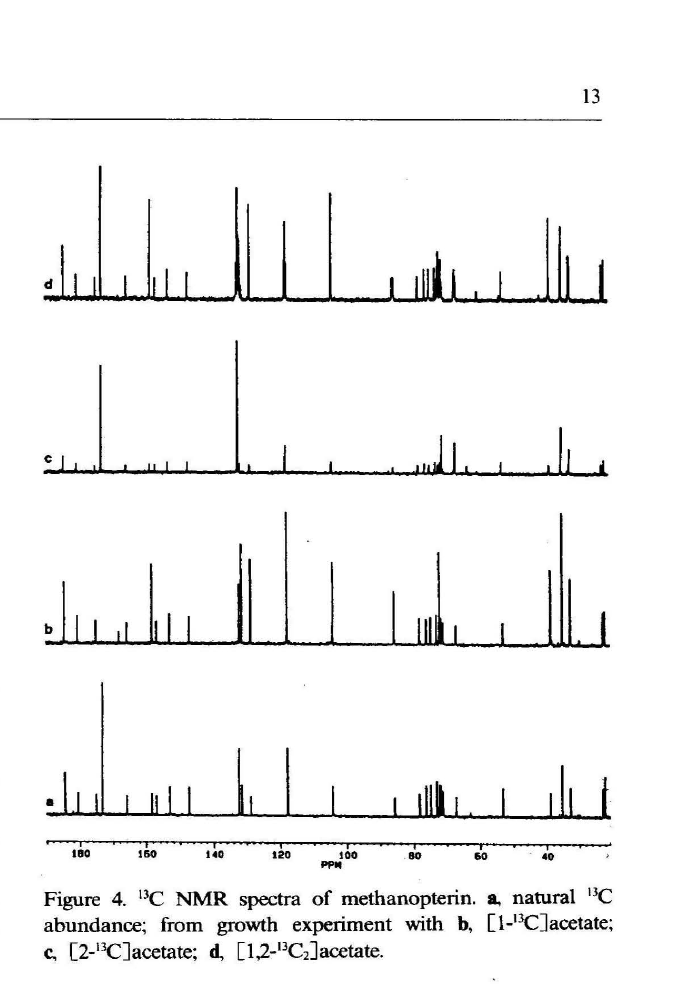
Table 2. Assignment of IH NMR and 13C NMR signals of the "hydrolytic fragment" (4)